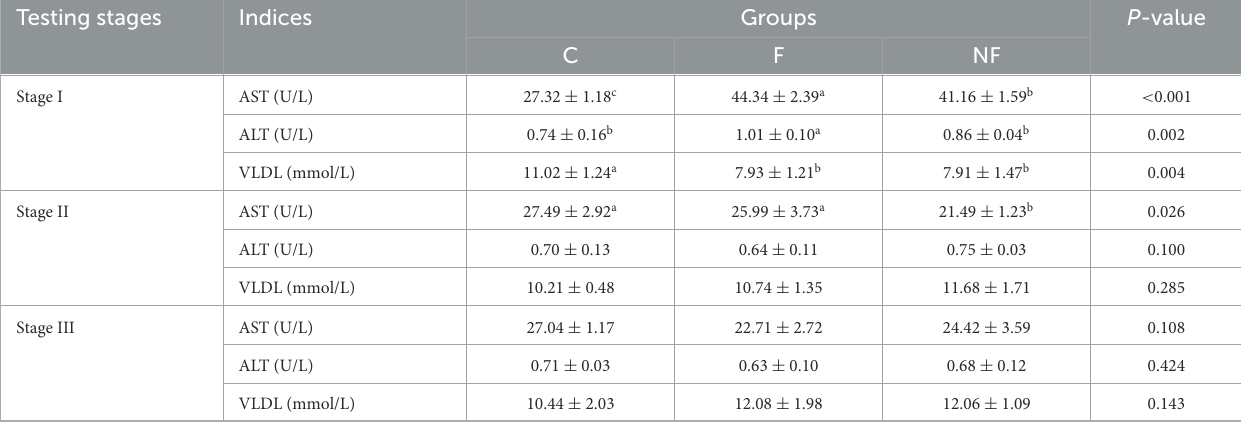
TABLE 5 Effects of non-fasting molting on serum biochemical indexes of laying hens.